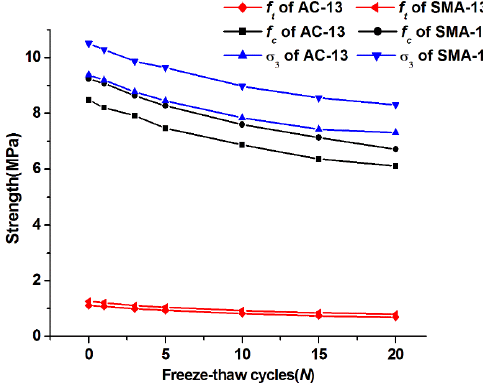
Figure 14. Strength of asphalt mixtures after freeze-thaw cycles.